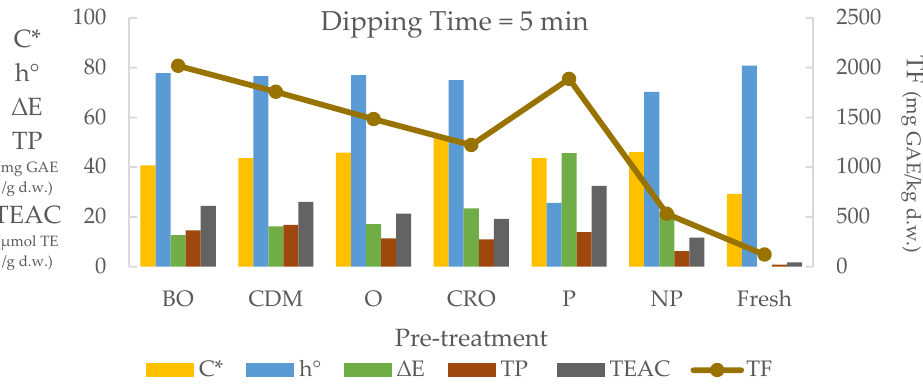
Figure 10. Effects of 5 min dipping time on quality parameters (tangerine ( Citrus deliciosa Mediter-